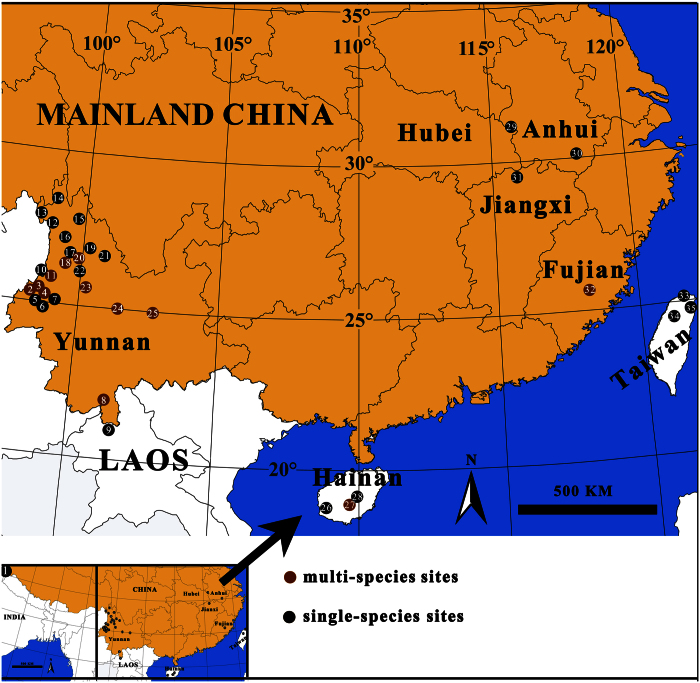
Map with sampling localities for each Pseudopoda species.1. JSM (Joshimath, India): P. prompta; 2. LYS (Langyashan Mountain, Yunnan): P. sp19, P. semiannulata, P. sp12, P. sp9; 3. YFS (Yunfengshan Mountain, Yunnan): P. sp19, P. sp12, P. sp1, P. sp6; 4. LJPZ (Linjiapuzi Protection Station, Yunnan): P. digitata, P. sp6, P. sinapophysis; 5. LFS (Laifengshan Mountain, Yunnan): P. namkhan; 6. HKBG (Haokang Botanical Garden, Yunnan): P. sp10; 7. TB (Taibao Park, Yunnan): P. namkhan; 8. XSBN (Xishuangbanna, Yunnan): P. confusa, P. namkhan; 9. BTM (Ban TavanMai, Luang Nam Tha district, Laos): P. confusa; 10. ABM (Anti-British Monument in pianma, Yunnan): P. sp2; 11. YJP (Yaojiaping Protection Station, Yunnan): P. gibberosa, P. interposita, P. sp15; 12. PLD (Puladi Village, Yunnan): P. sp13; 13. KD (Kongdang Village, Yunnan): P. sp14; 14. FLS (Feilaisi Temple, Yunnan): P. sp18; 15. WFS (Wufengshan Mountain, Yunnan): P. yunnanensis wfs; 16. WCT (Wenchangta Tower, Yunnan): P. bibulba we; 17. MLP (Maliping Village, Yunnan): P. sp11; 18. EWS (Erwushan Mountain, Yunnan): P. yunnanensis ews, P. bibulba we; 19. HLT (Heilongtan Park, Yunnan): P. sp18; 20. QSS (Qianshishan Mountain, Yunnan): P. sp11, P. yunnanensis qss; 21. LYST (Lingyuanshi Temple, Yunnan): P. sp17; 22. YLS (Yuelingshan Mountain, Yunnan): P. sp8; 23. CS (Cangshan Mountain, Yunnan): P. cangschana, P. daliensis, P. rivicola, P. signata; 24. ZXS (Zixishan Mountain, Yunnan): P. bibulba xz, P. sp7, P. sp16, P. signata; 25. XS (Xishan Mountain, Yunnan): P. bibulba xz, P. kunmingensis, P. roganda, P. spiculata; 26. JFL (Jianfengling Mountain, Hainan): P. bicruris; 27. WZS (Wuzhishan Mountain, Hainan): P. bicruris, P. mediana; 28. BHL (Baihualing Mountain, Hainan): P. bicruris; 29. TTZ (Tiantangzhai National Forest Park, Hubei): P. tiantangensis; 30. HS (Huangshan Mountain, Anhui): P. sp3; 31. LS (Lushan Mountain, Jiangxi): P. lushanensis; 32. DYS (Daiyunshan Mountain, Fujian): P. sp4, P. sp5; 33. YMS (Yangmingshan Mountain, Taiwan): P. recta; 34. GWS (Guanwushan Mountain, Taiwan): P. recta; 35. LL (Loulan forest Park, Taiwan): P. serrata. The map was generated by ArcView GIS 3.2 (http://www.esri.com/software/arcgis/arcview).